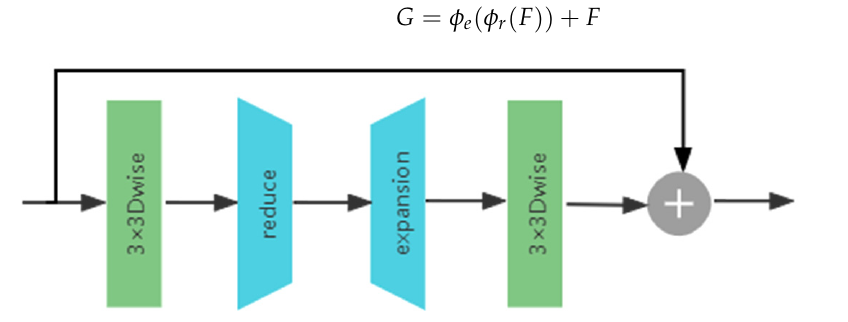
Figure 6. Structural drawing of SandGlass block. Table 1. The SandGlass block’s